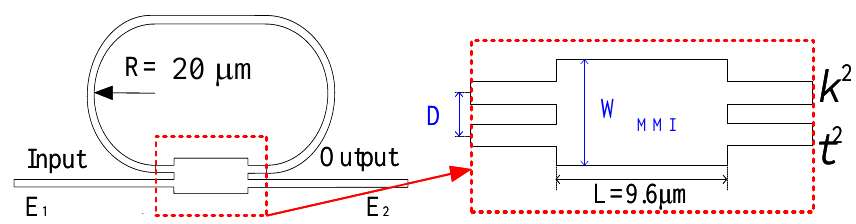
Figure 1. A ring resonator using a MMI